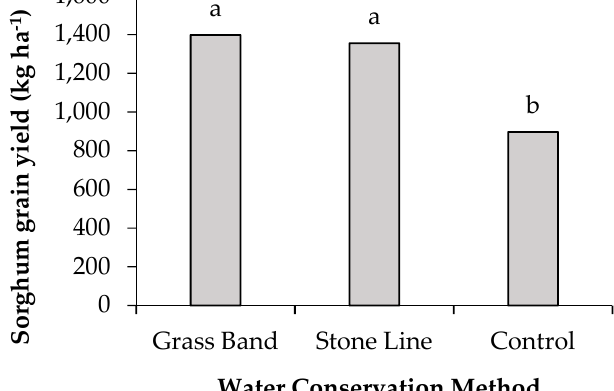
Figure 6. Sorghum grain yield as affected by water conservation methods at Saria Research Station, Burkina Faso, in 2010. Columns with the same letter are not significantly different at p ≤ 0.05.